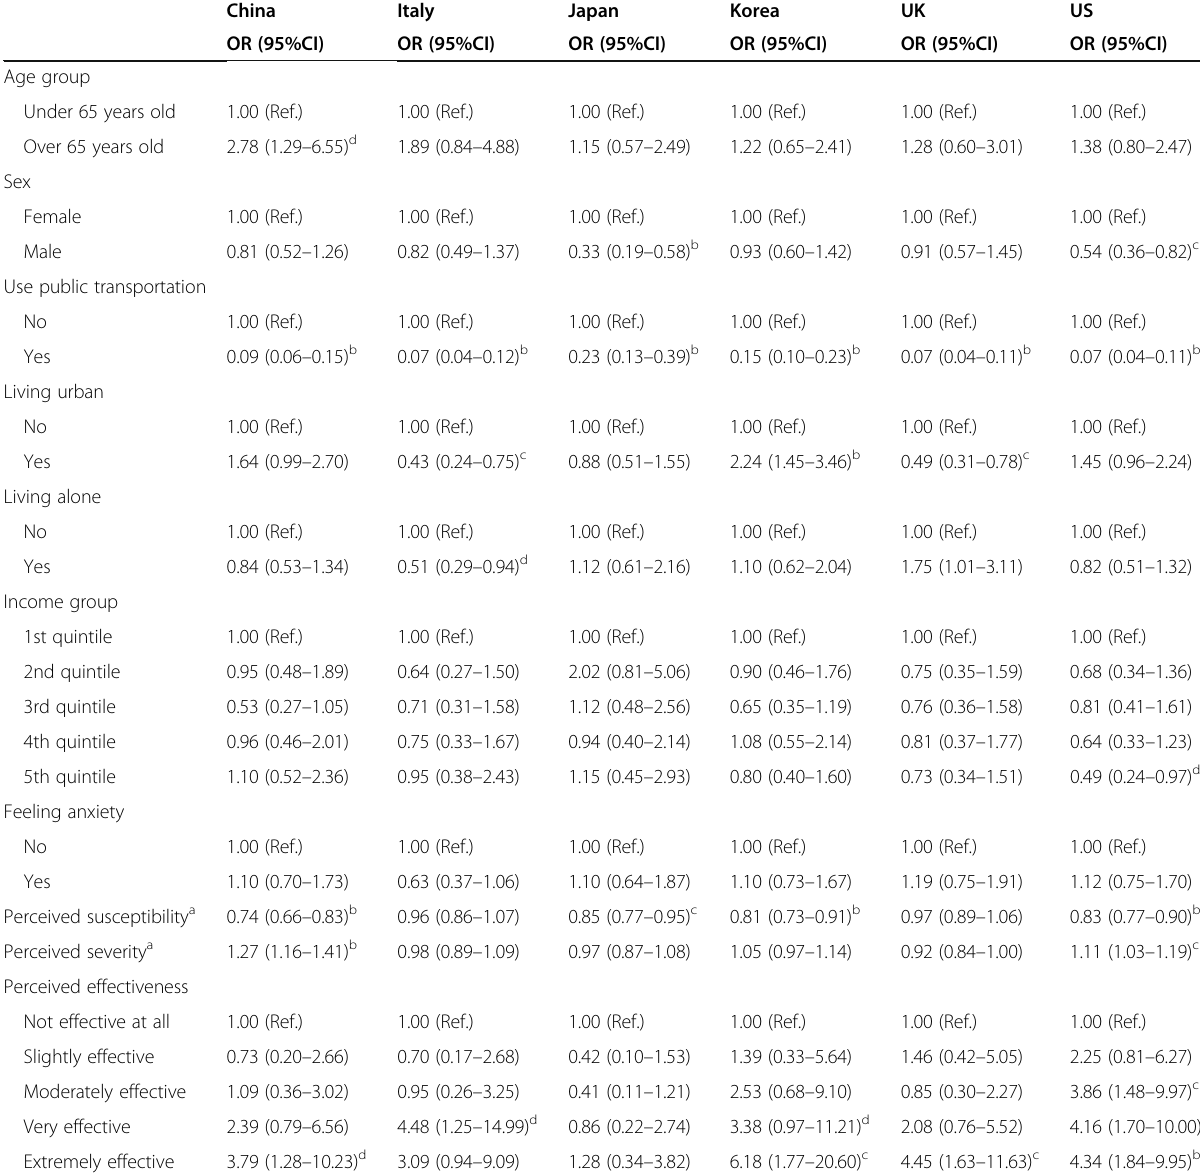
Table 5 Associations between public perceptions, personal characteristics, and avoiding social gathering